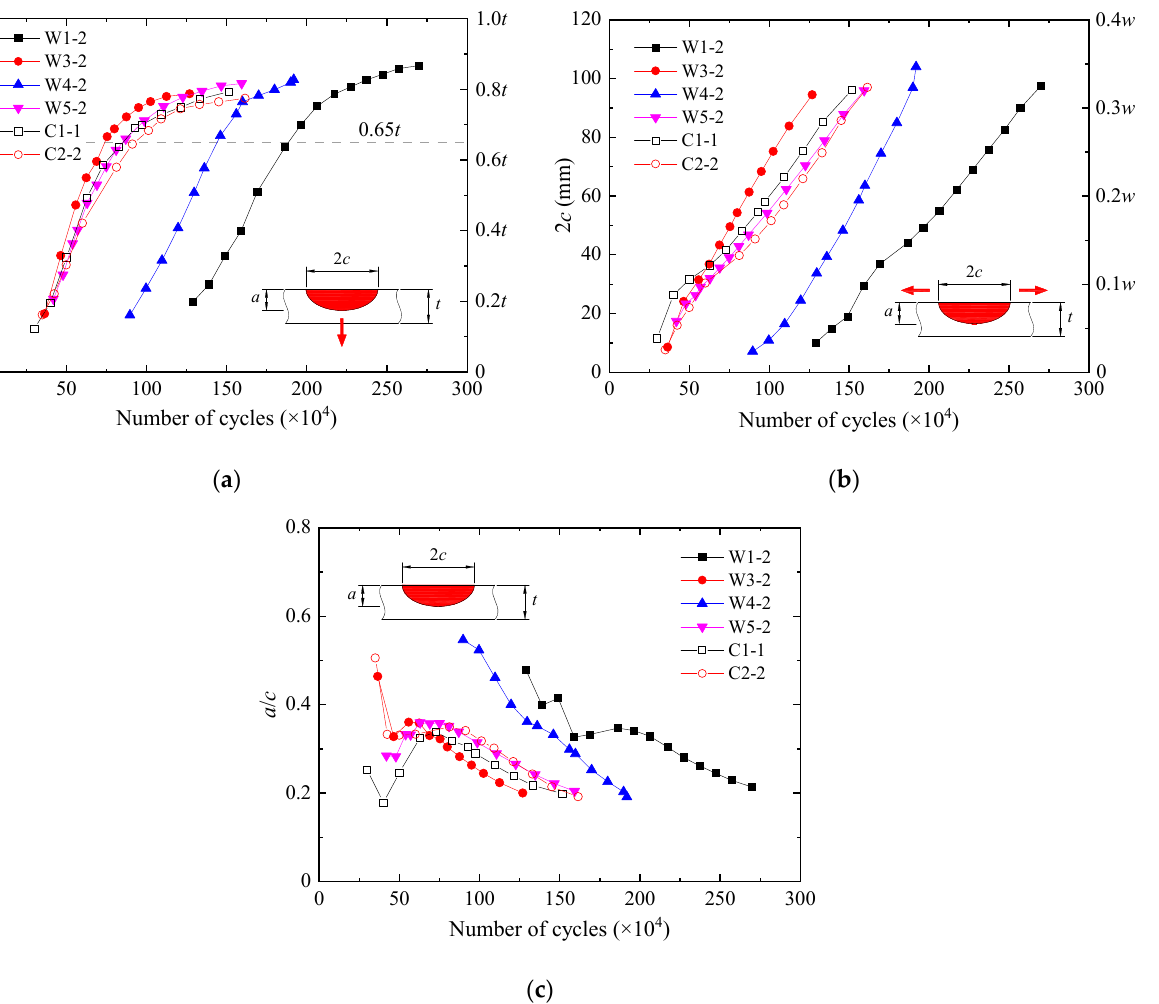
Figure 11. Fatigue crack propagation characteristics. ( a ) Crack depth. ( b ) Crack width. ( c ) Aspect ratio of crack.